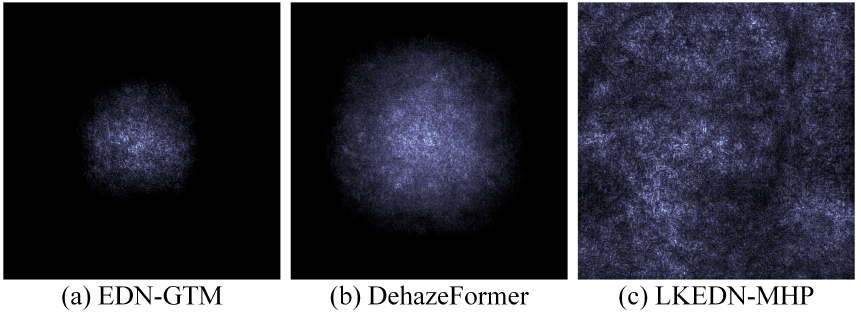
Figure 7. The ERFs of EDN-GTM, DehazeFormer, and LKEDN-MHP, respectively. A more widely distributed bright area indicates a larger ERF. We measure the effective receptive field of different layers as the absolute value of the gradient of the center location of the feature map with respect to the input. Results are averaged across all channels in each map for 32 randomly-selected images. In many classical computer vision tasks, the Dice score and Jaccard index are used to evaluate the segmentation performance [47]. The results compared with the state-of-the-art methods are shown in Figure 8 and Table 2.